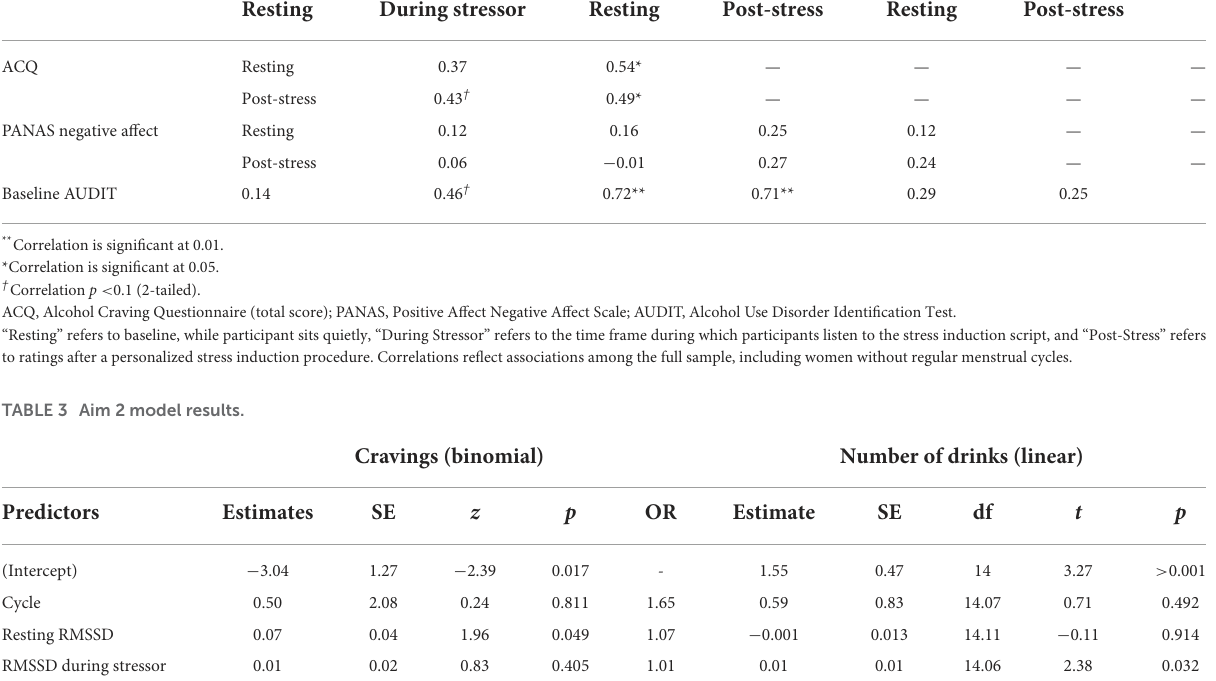
TABLE 2 Correlation (Pearson’s r ) of variables of interest. RMSSD ACQ PANAS negative affect Resting During stressor Resting Post-stress Resting Post-stress